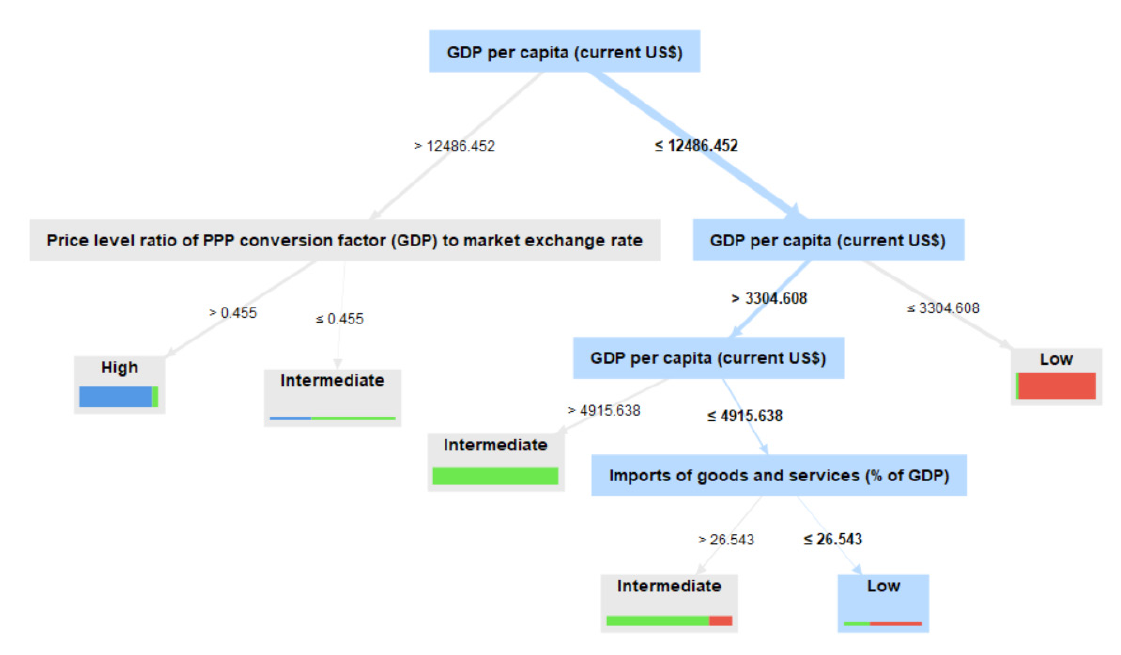
Figure 3. Decision tree for classification of environmental performance